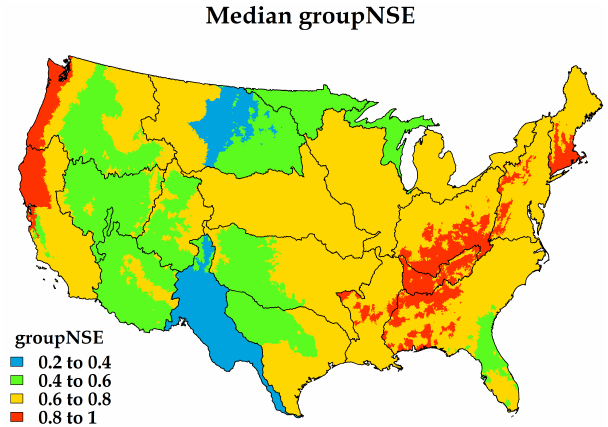
Figure 14. Median Nash–Sutcliffe efficiency (NSE) of streamgages used for calibration by calibration